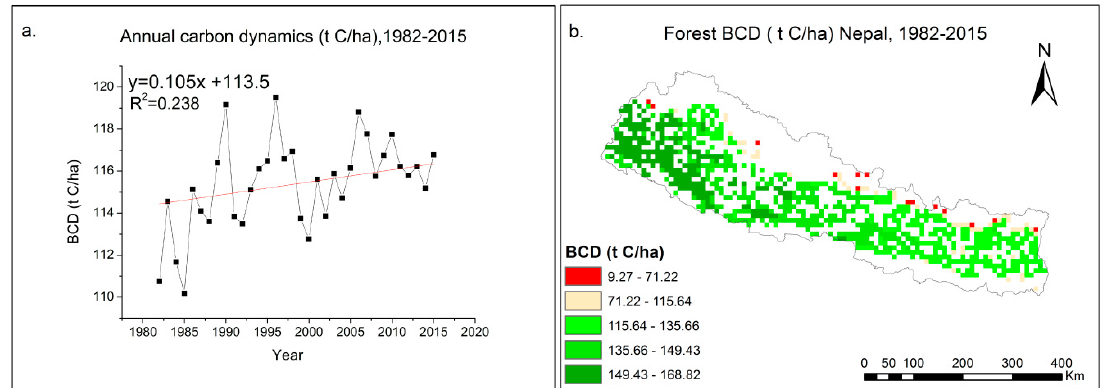
Figure 6. The temporal and spatial variation of BCD (t C/ha) in Nepal: ( a ) temporal variation of BCD (t C/ha); ( b ) spatial variation of forest BCD (t C/ha) in Nepal, 1982–2015.